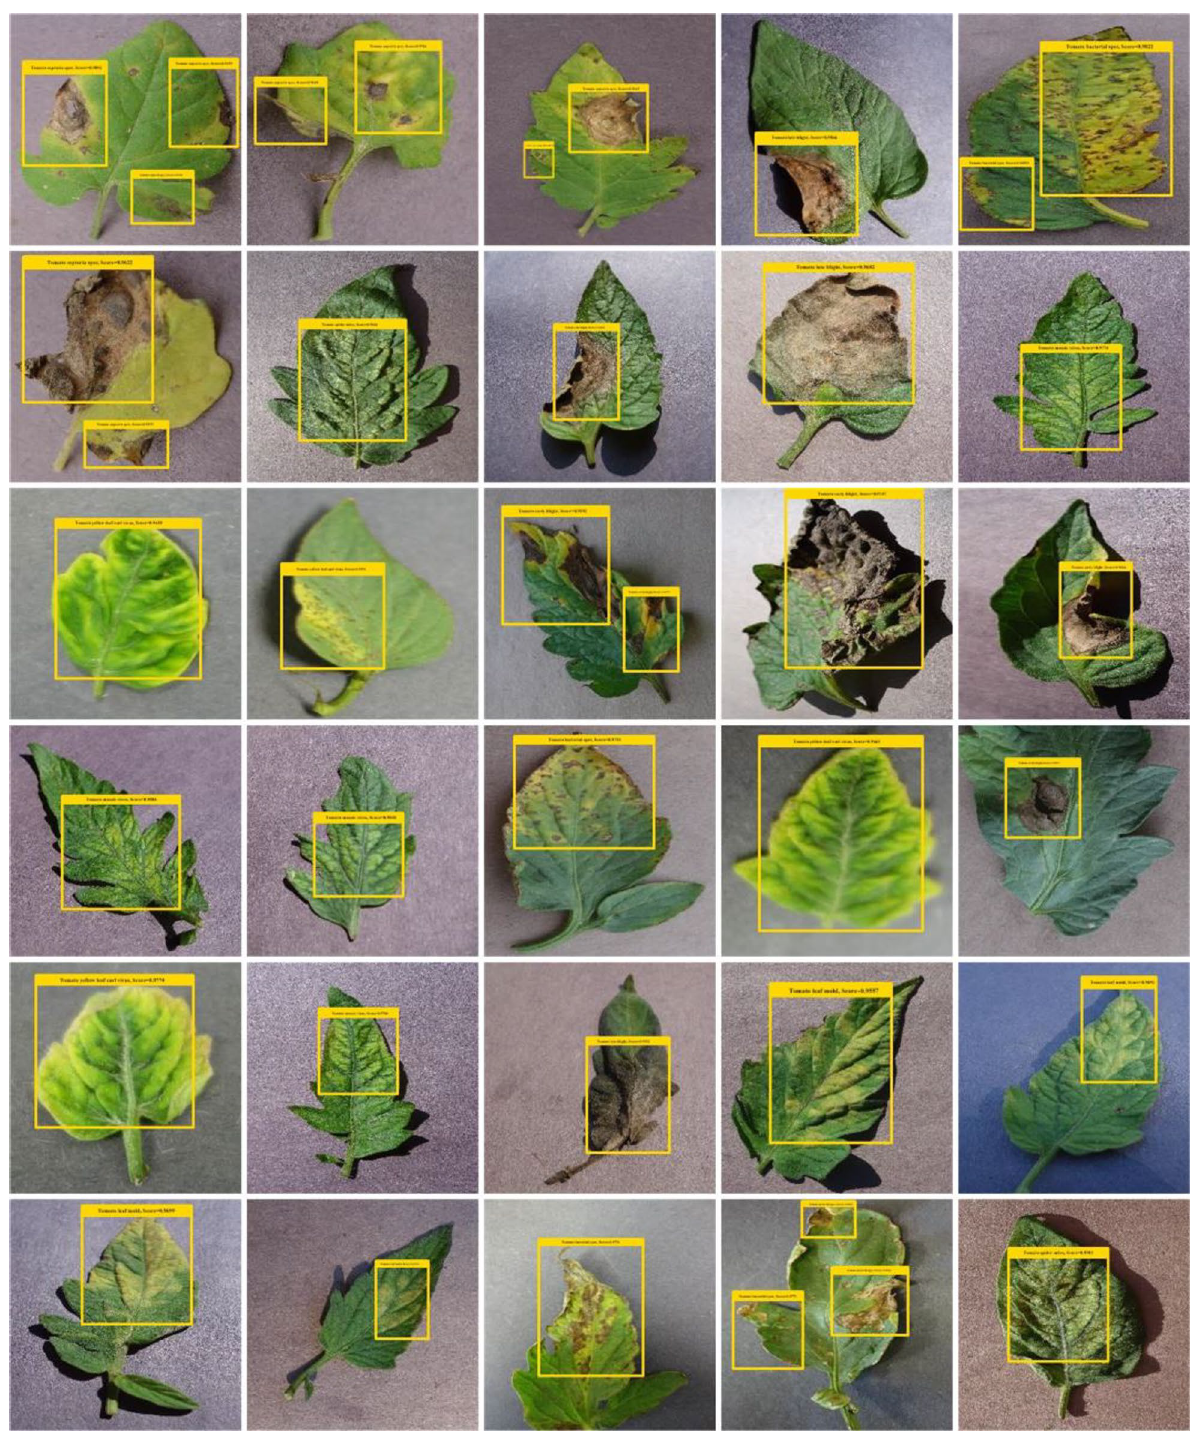
Figure 7. Localization